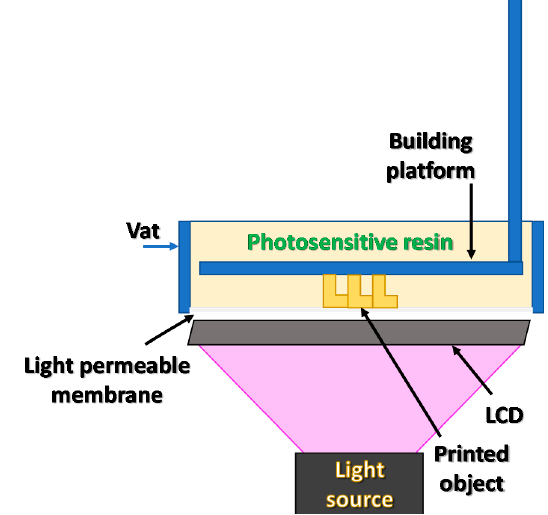
Figure 5. A schematic representation of an LCD–digital light processing (DLP) 3D printer.